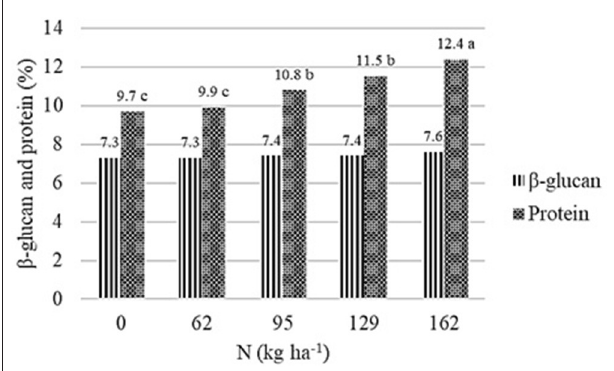
FIGURE 1 | Effect of N rate on β -glucan and protein content of barley across all locations and years. Dissimilar letters in a column are significantly different at p ≤ 0.05.